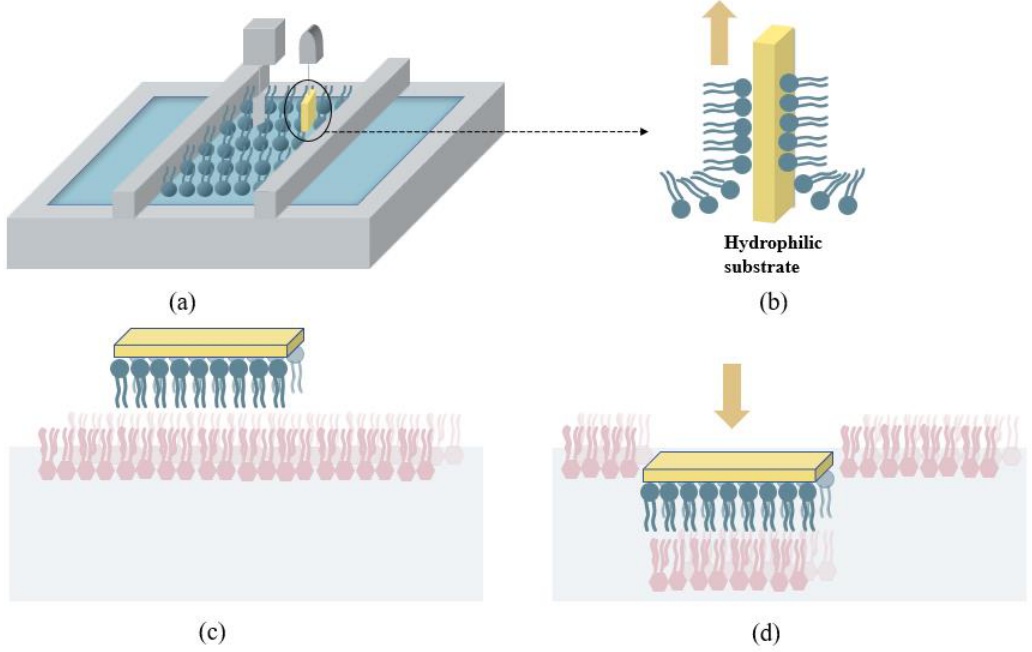
Figure 4. A schematic representation of vertical Langmuir – Blodgett and horizontal Langmuir – Schaefer depositions. ( a ) The phospholipid monolayer is compressed to the desired surface pressure at the air – water interface. ( b ) The phospholipid monolayer is transferred to the hydrophilic substrate by vertically lifting the substrate. ( c ) The Langmuir – Blodgett deposited monolayer is suspended above the air – liquid interface of the LPS monolayer. ( d ) The silicon crystal with the deposited Langmuir – Blodgett film is lowered to the interface to form bilayer with LPS monolayer.